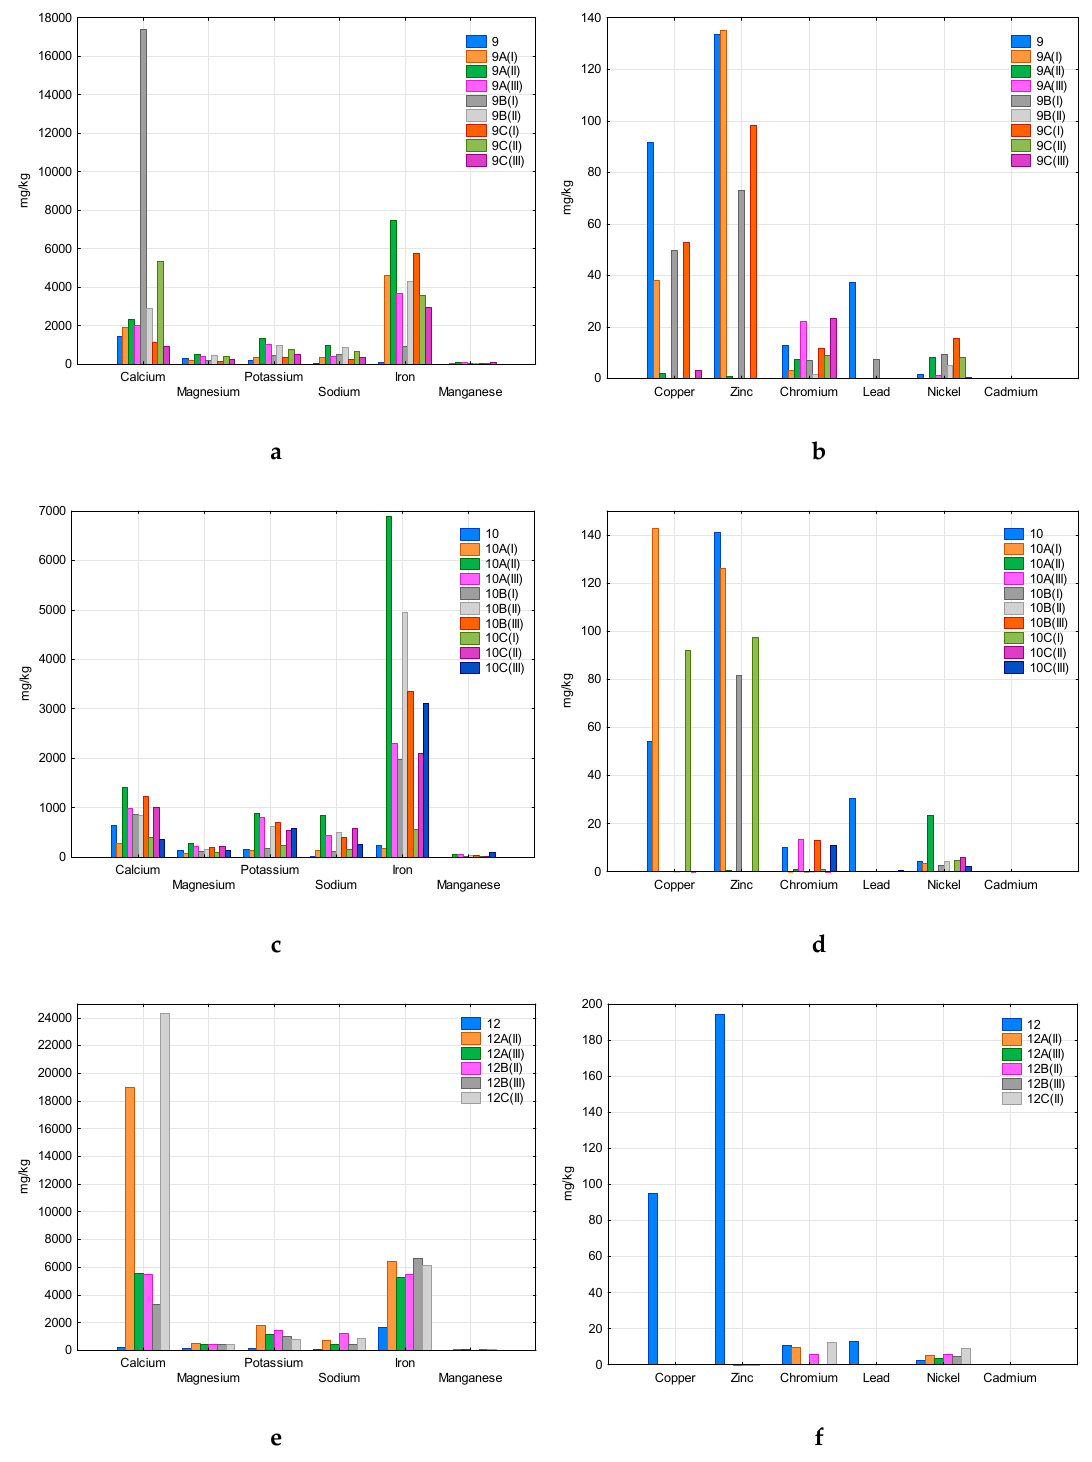
Figure 5. Comparison of the content of analysed metals in new and composted samples 9 ( a —macroelements, b —heavy metals), 10 ( c —macroelements, d —heavy metals), and 12 ( e —